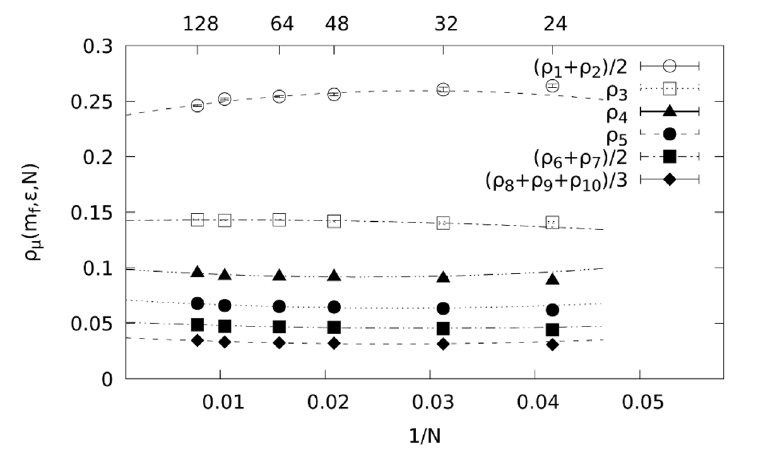
Figure 1 . The large- N extrapolation of (cid:26) (cid:22) ( m f ; (cid:15); N ) for m f = 1 : 0, (cid:15) = 0 : 2 with m (cid:22) = (0 : 5 ; 0 : 5 ; 1 ; 2 ; 4 ; 8 ; 8 ; 8 ; 8 ; 8). The (cid:26) (cid:22) ( m f ; (cid:15); N ) are averaged for (cid:22) = 1 ; 2, (cid:22) = 6 ; 7 and (cid:22) = 8 ; 9 ; 10 to increase statistics. A quadratic (cid:12)t with respect to 1 =N is